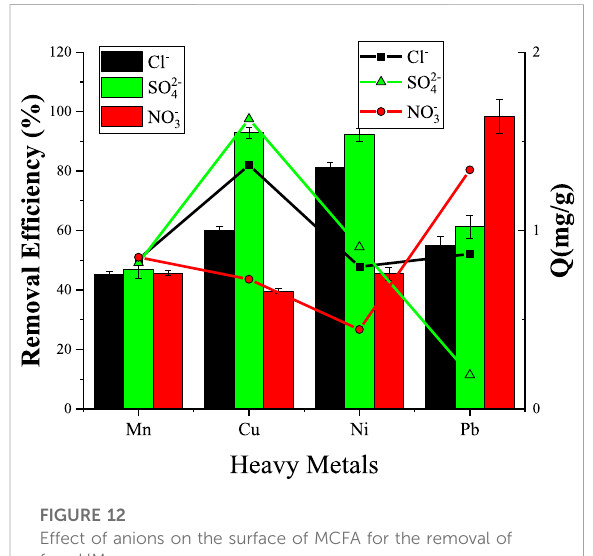
FIGURE 12 Effect of anions on the surface of MCFA for the removal of four